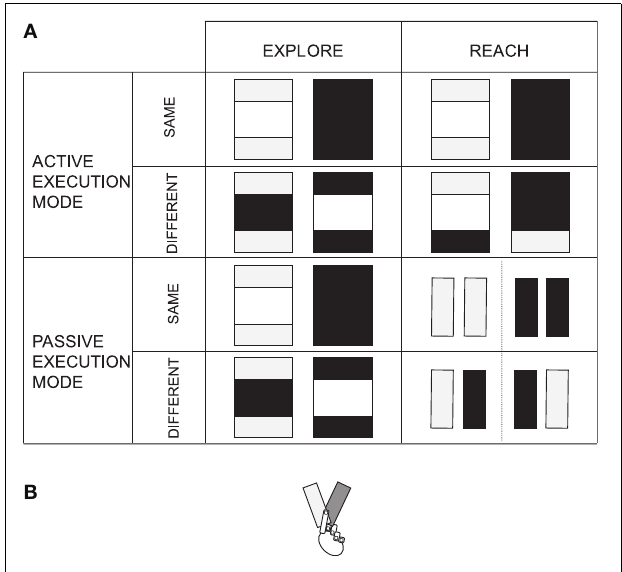
FIGURE 2 | (A) Schematic drawings of the types of boards used, split according to the different experimental conditions. Dark shades of gray represent one type of material (i.e., cling film), and lighter shades of gray represent the other material (i.e., tinfoil). (B) Schematic depiction of the V-shape arrangement of the boards in experimenter’s hand, used for the passive discrimination